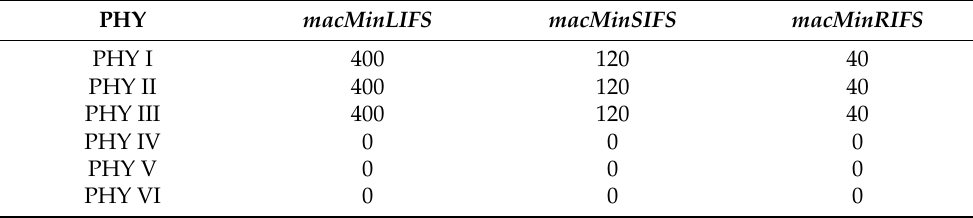
Table 1. Inter Frame Spacing ( IFS ) values for physical layer (PHY) layers in optical clocks. PHY macMinLIFS macMinSIFS PHY